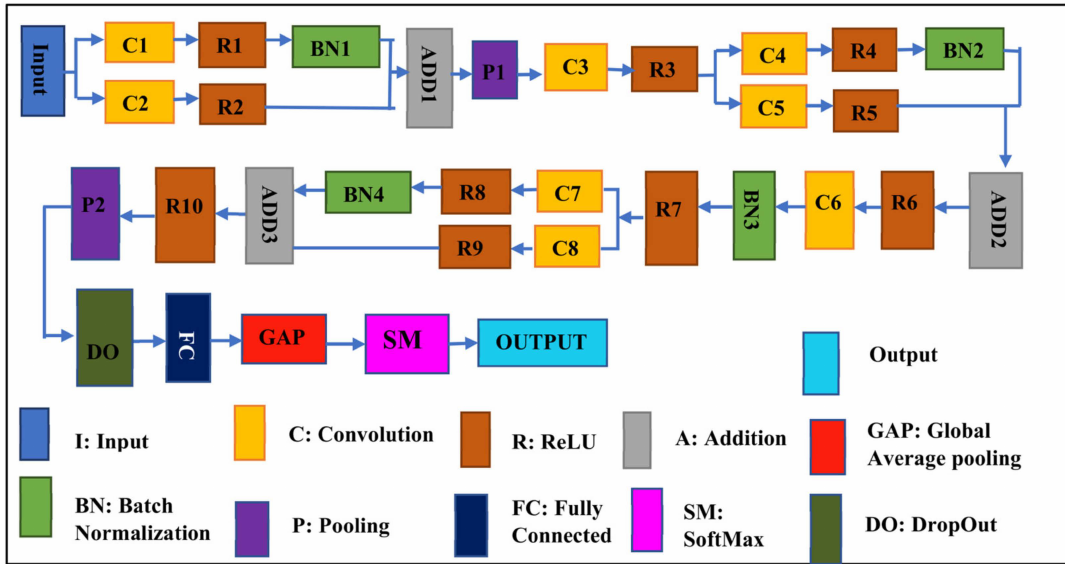
Figure 3. The architecture of the proposed CNN network,